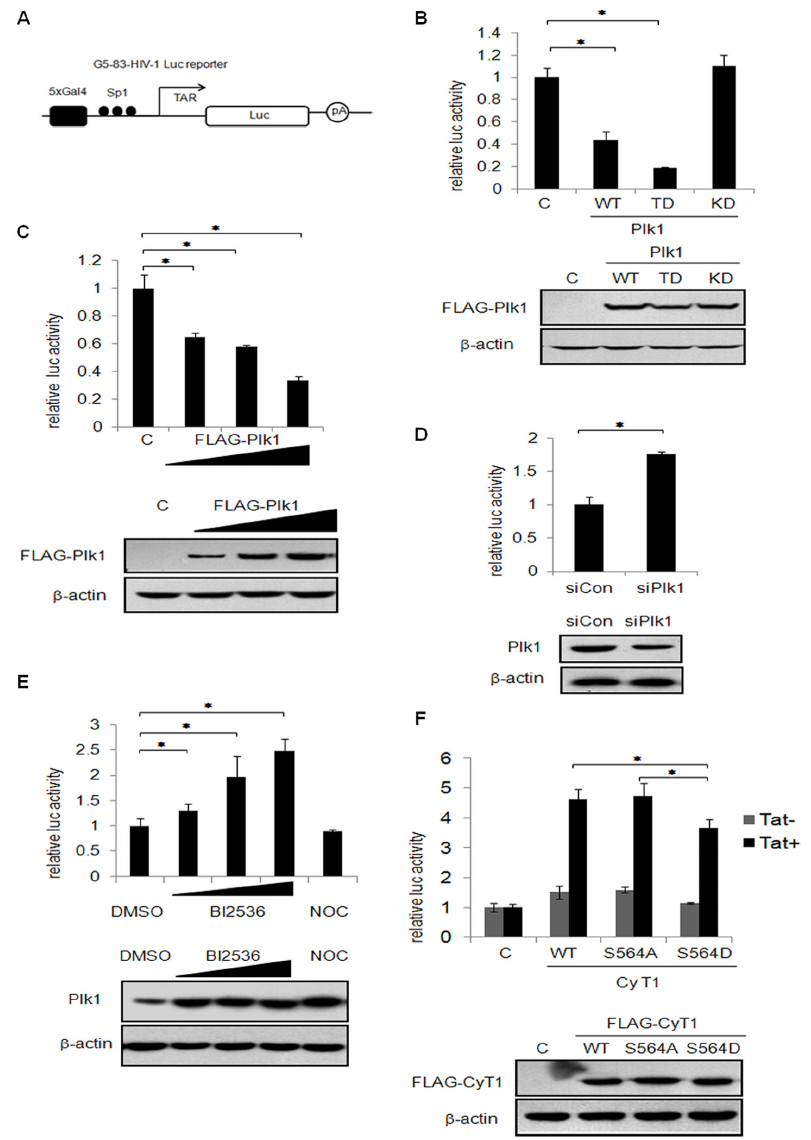
Figure 5. Plk1 represses P-TEFb-dependent transcription. (A) Schematic map of G5-83-HIV-Luc reporter. (B) 293T cells were co-transfected with Plk1, Plk1 TD or Plk1 KD expression plasmids and HIV-1 LTR luciferase reporter for 36 h. The cell lysates